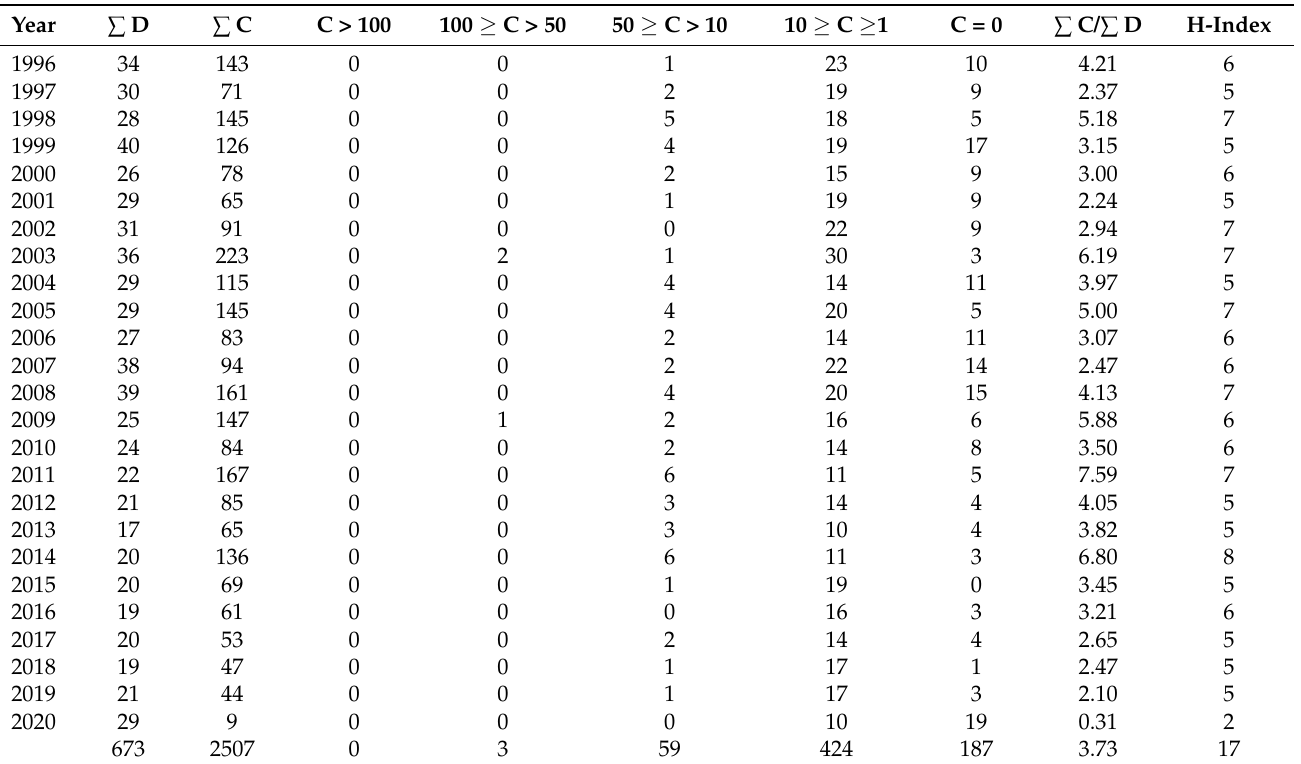
Table 3. Summary of citations received by the journal according to the year of publication of the articles.